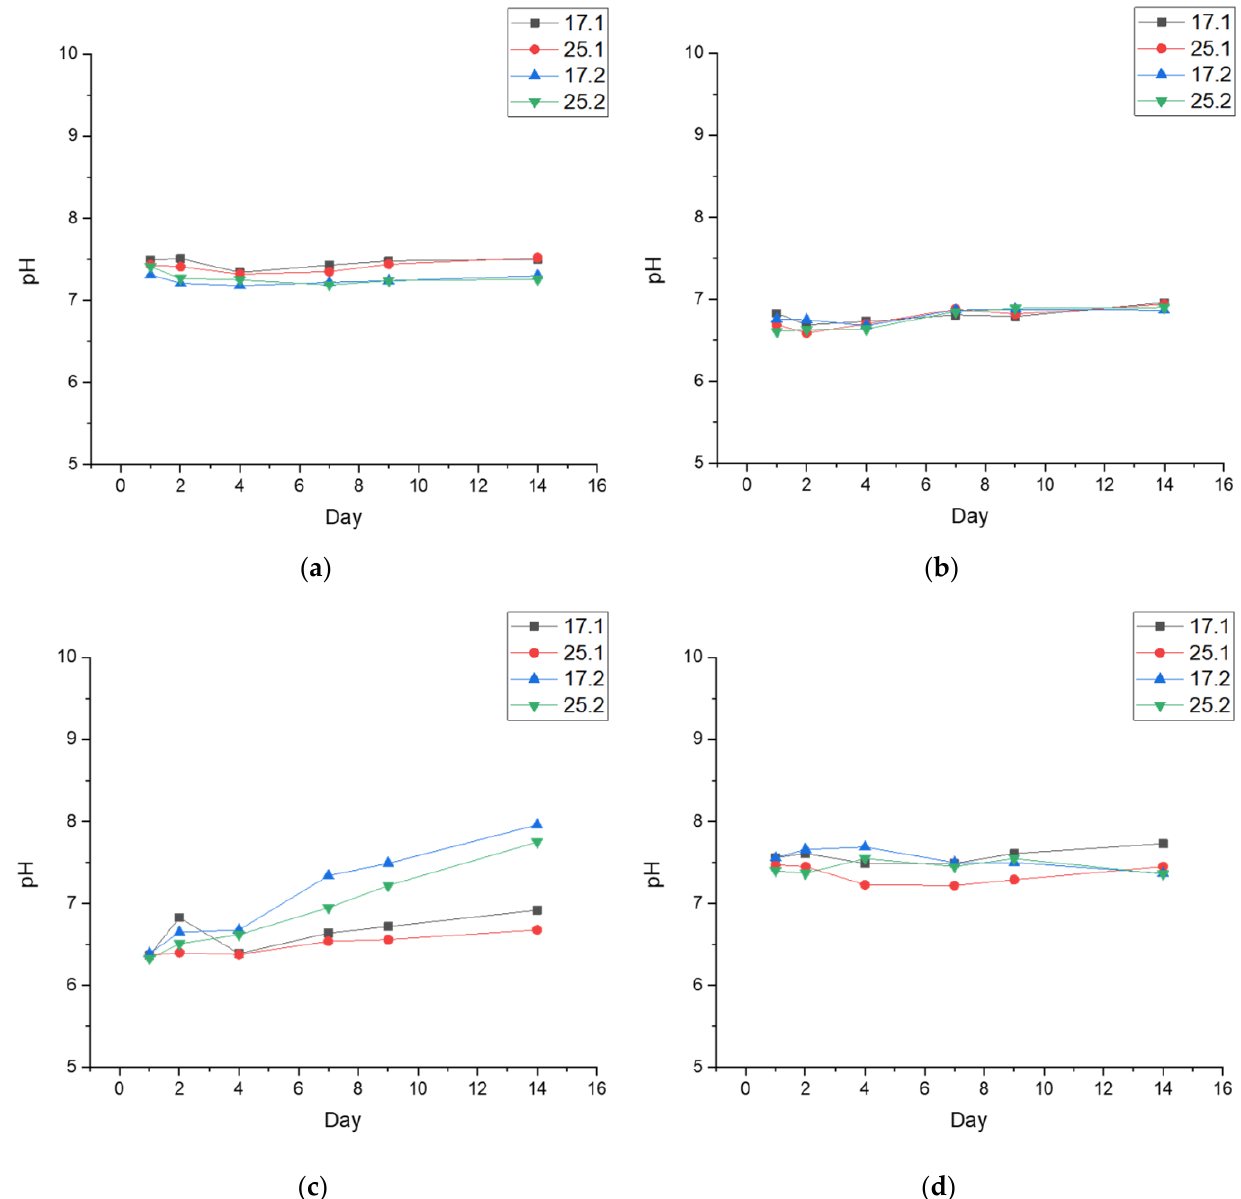
Figure 3. Measured pH values of: ( a ) PBS; ( b ) Ringer’s fluid; ( c ) artificial saliva; ( d ) distilled water.